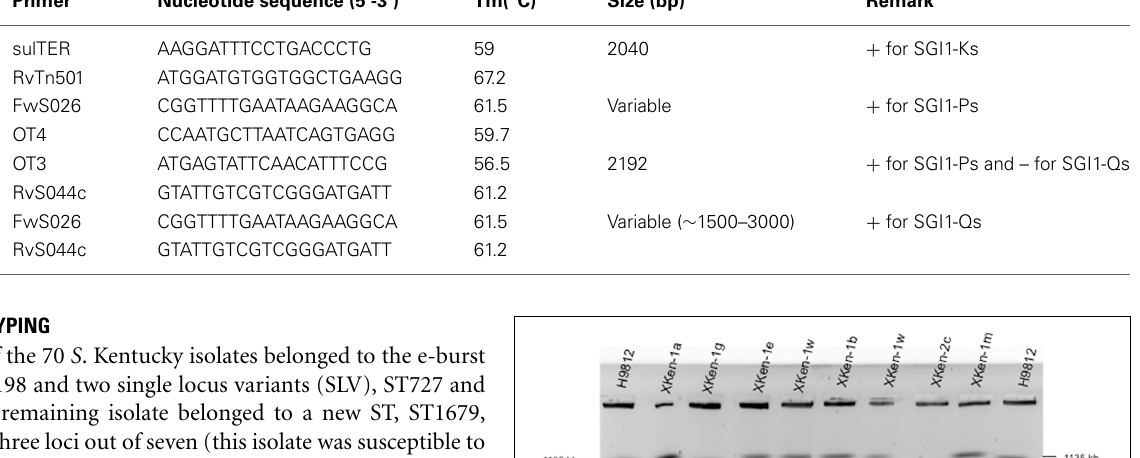
Table 2 | PCR set (SGI1- Ks, -Ps, and -Qs). PCR No.